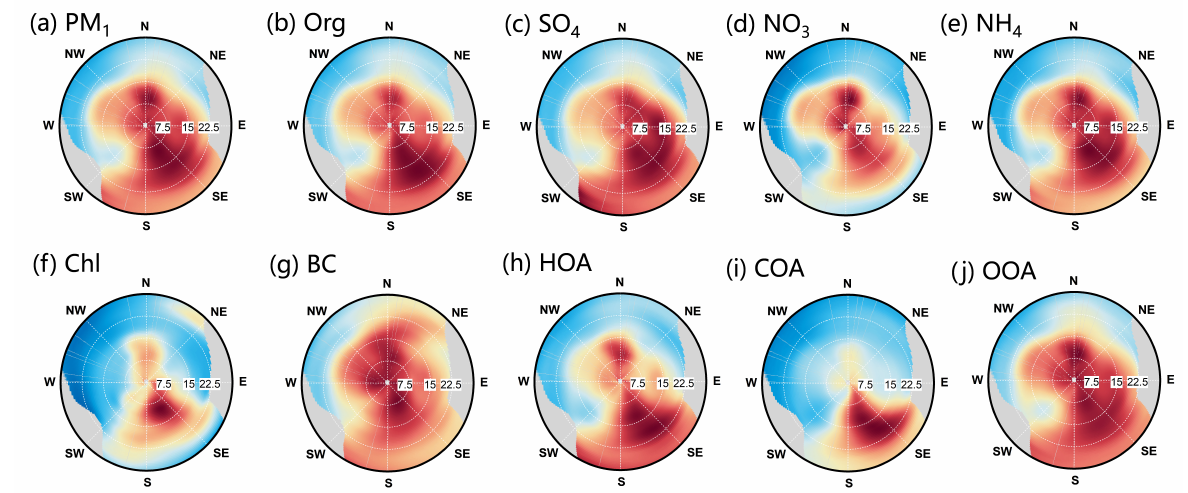
Figure 5. Bivariate polar plots of PM 1 species as a function of wind speed and wind direction: (a) PM 1 , (b) Org., (c) SO 4 , (d) NO 3 , (e) NH 4 , (f) Chl, (g) BC, (h) HOA, (i) COA, and (j) OOA. The color scales in (a–j) range from 0 to 44, 17, 11, 7.2, 4.5, 1.9, 4.1, 2.0, 2.7, and 12µgm − 3 ,